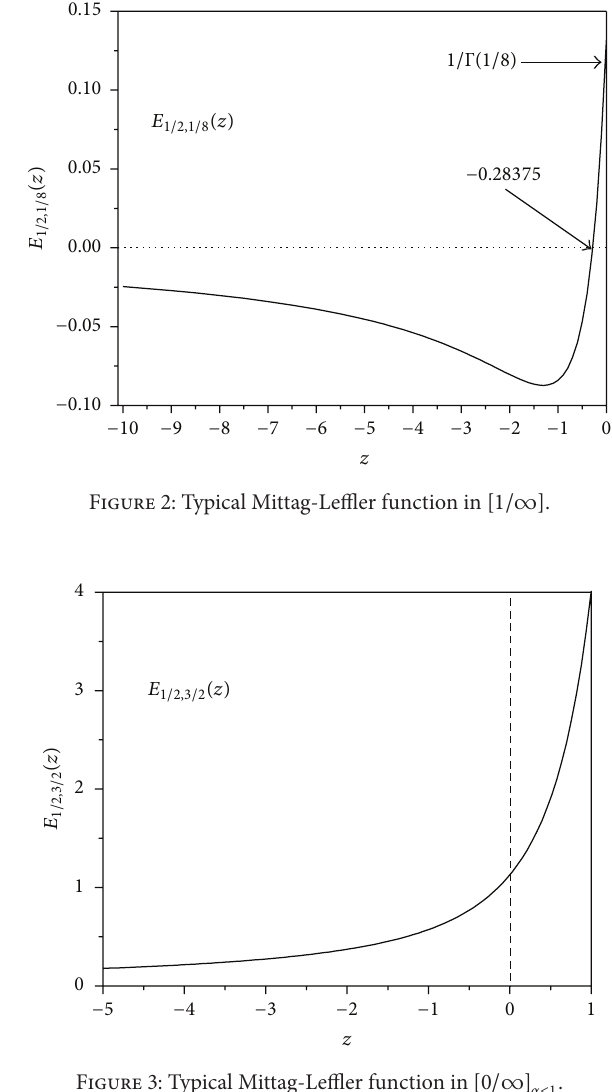
Figure 3: Typical Mittag-Leffler function in [0/∞] 𝛼<1 .